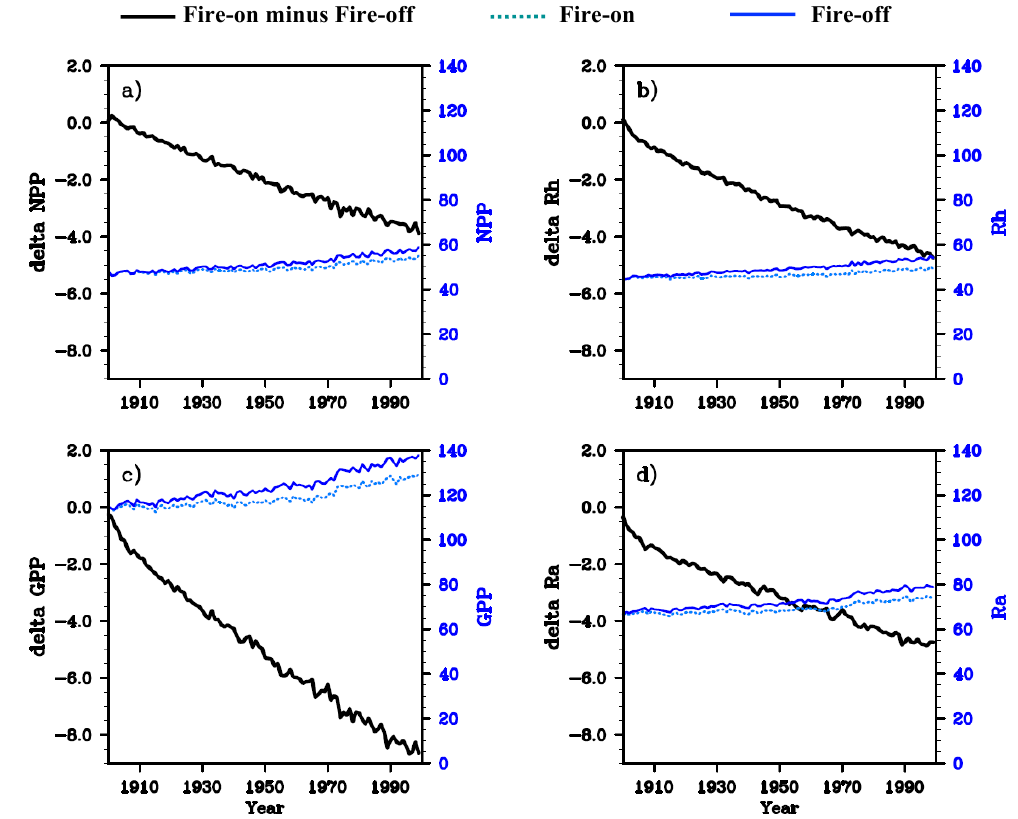
Fig. 7. Same as Fig. 5b and c, but for (a) NPP, (b) Rh, (c) GPP, and (d) Ra.